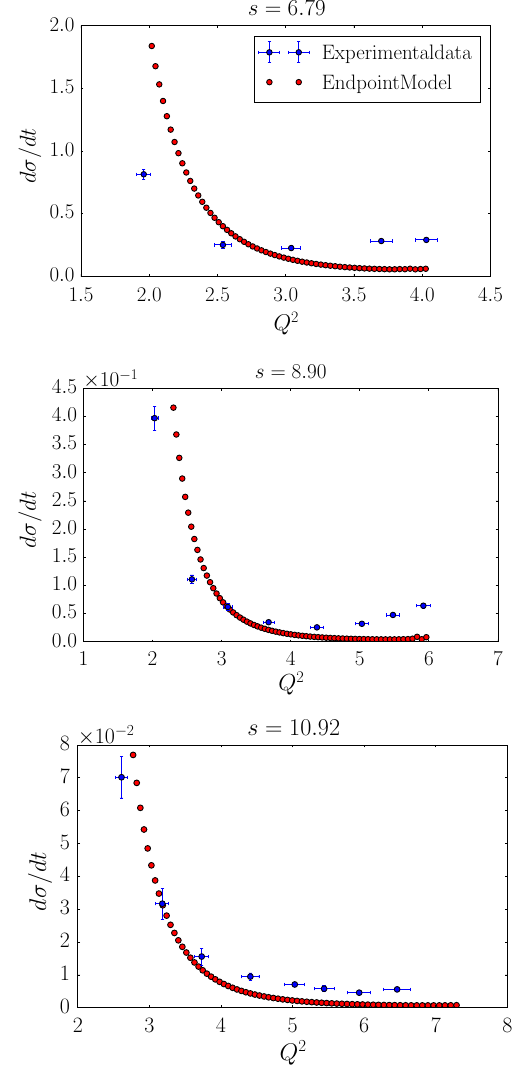
Fig. 2 Plot of d σ/ dt nbarns/GeV 2 vs t for s = 6.79, 8.90, 10.92 GeV 2 and m =0.11 GeV; v = 41.25, a = 0, t = 38.26 (GeV − 2